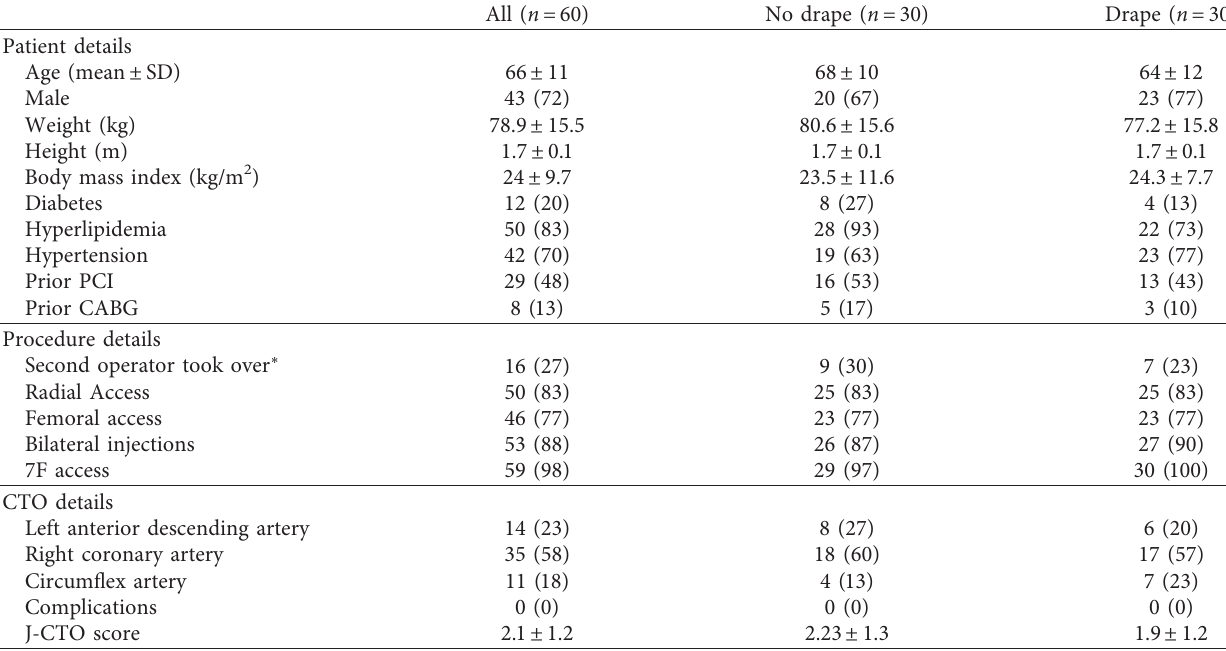
Table 1: Patient, theatre, and procedural details.